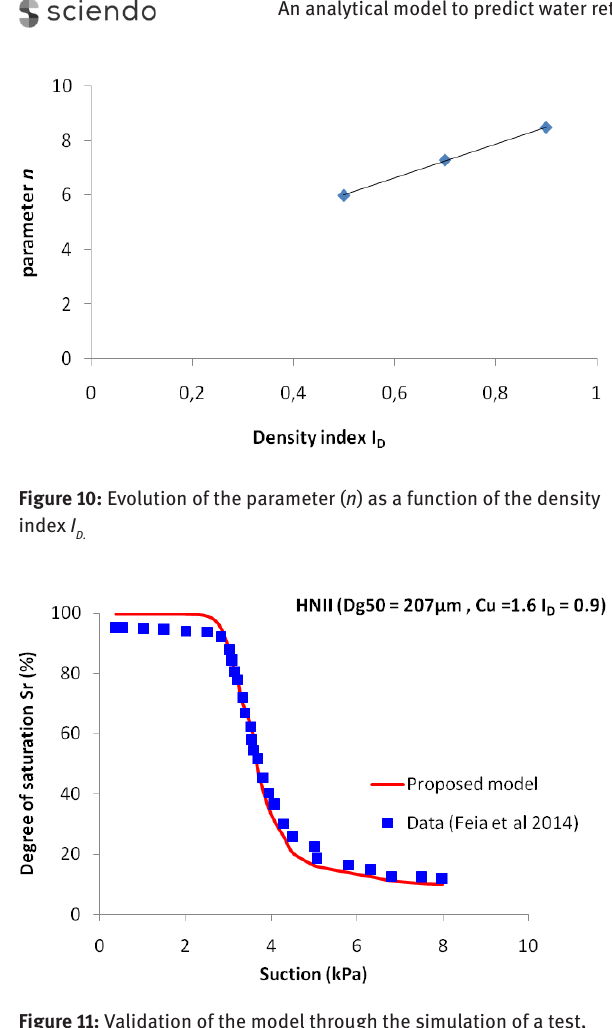
Figure 11: Validation of the model through the simulation of a test, with a density index I =0.9 and uniformity coefficient C D